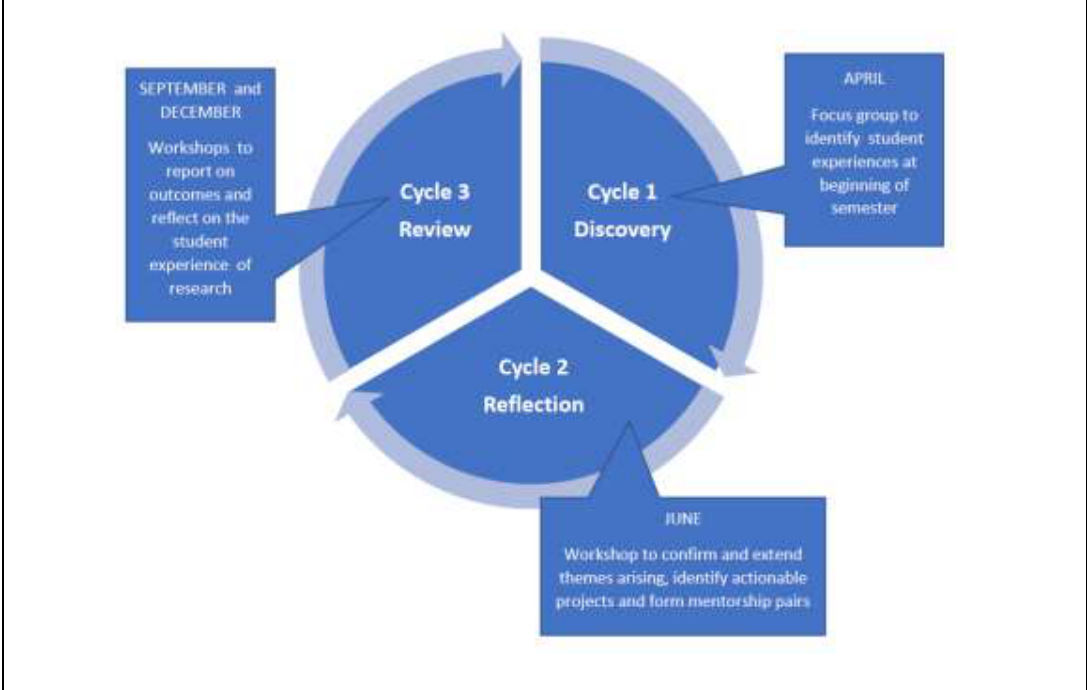
Figure 1. The Action Research